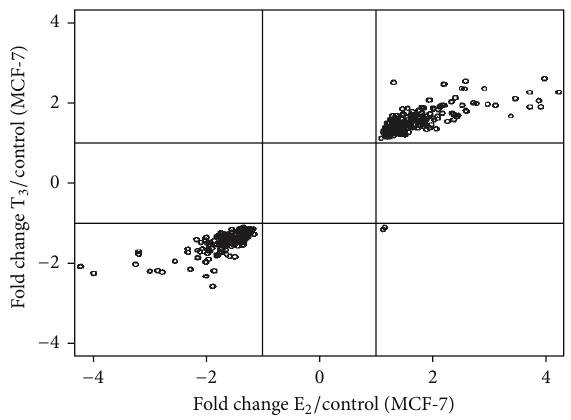
Figure 1: Dispersion of fold changes for the 393 genes modulated by E 2 and T 3 in MCF-7 cells. Each point represents the expression of one gene. The dispersion is similar in both treatments for all except two genes.